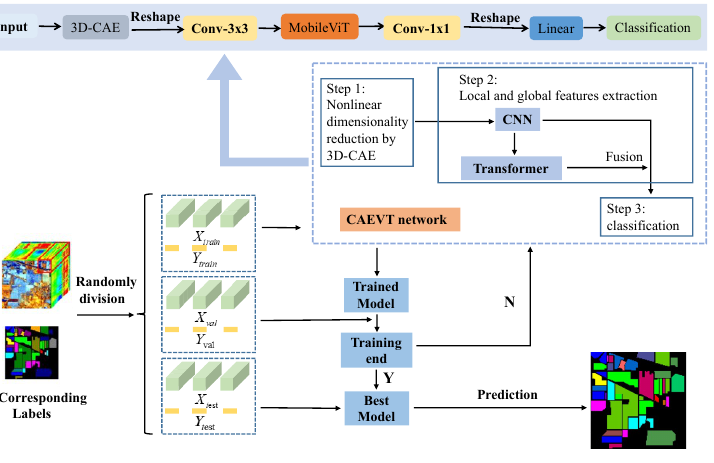
Figure 4. Flowchart of the proposed